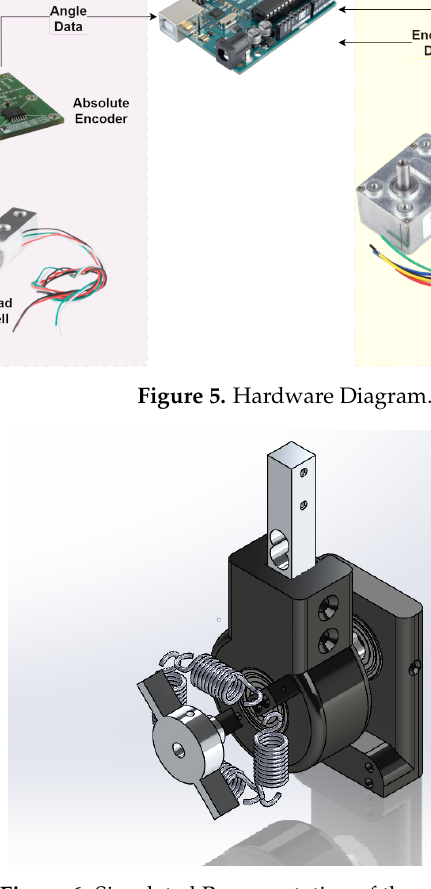
Figure 6. Simulated Representation of the non-rigid